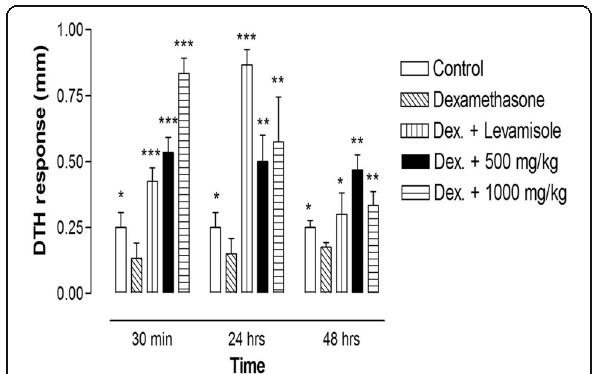
Fig. 2 Effect of T. clypeatus extract on DTH response using CRBC in Dexamethasone treated mice. Histogram represent Means ± SD ( n = 5). Means with signs*, ** and ***superscripts are significantly different as compared to dexamethasone control at the level of 0.05 ( p <